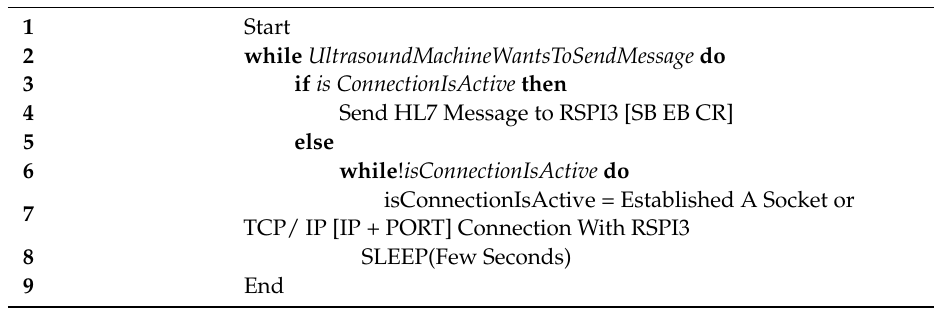
Algorithm 1: Ultrasound Machine to RSPI3 Message